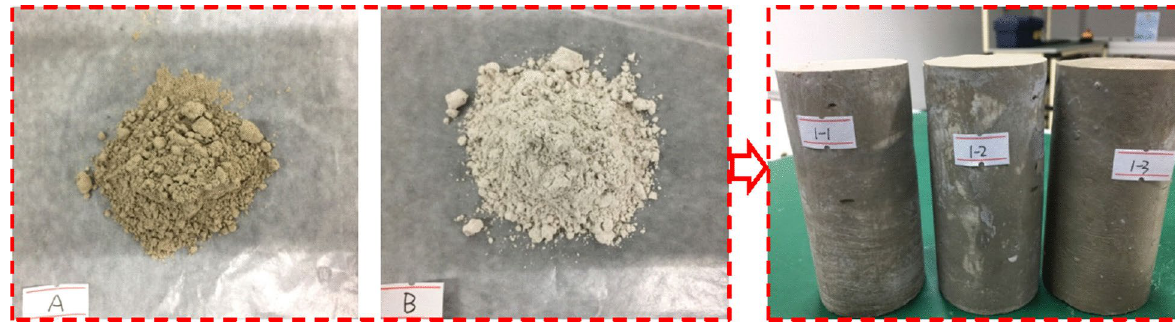
Fig. 5 Preparation process for standard specimens of high-water